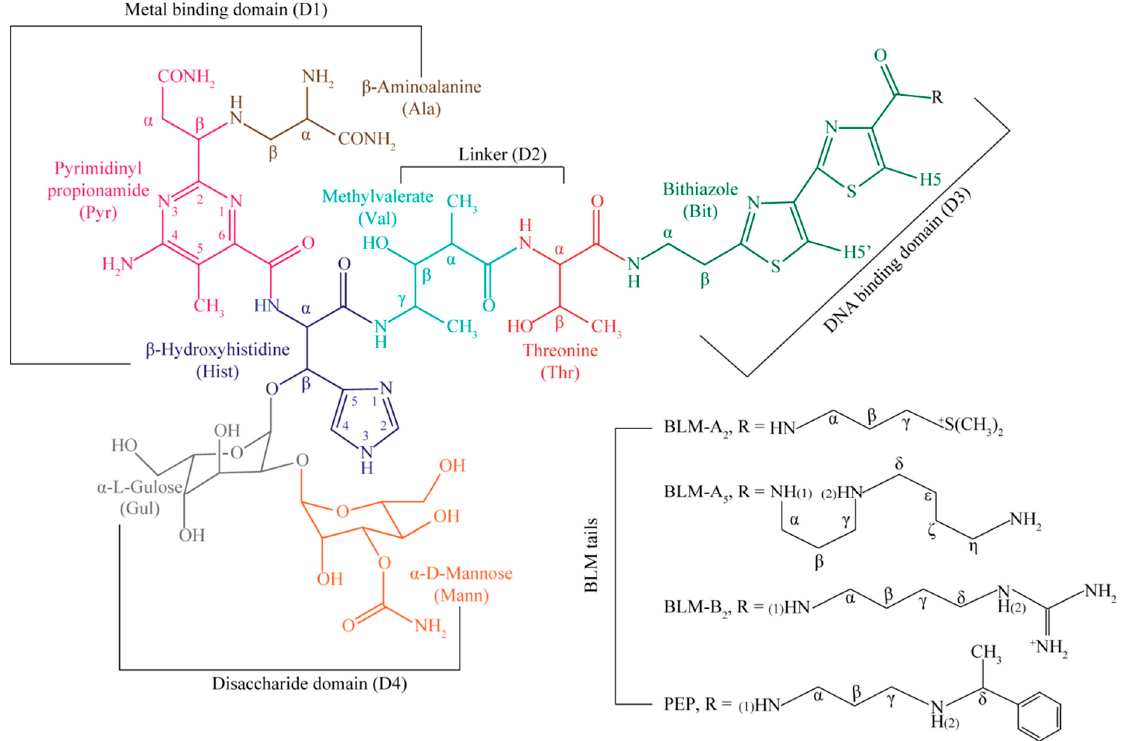
Figure 1. Structures BLM-A 2 , -A 5 , -B 2 , and PEP showing the breakdown of the different domains, residues, and C-termini.